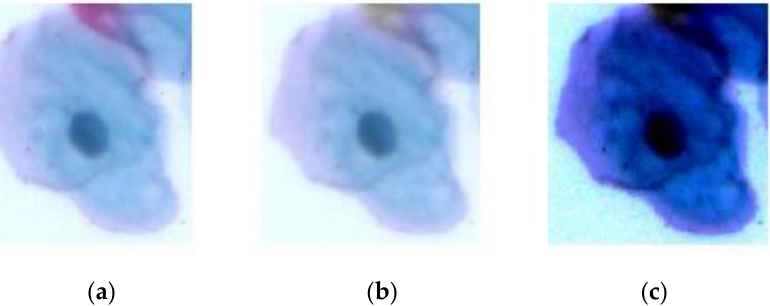
Figure 3. Image enhancement: ( a ) original image, ( b ) noise removal via the median filter, and ( c ) contrast enhancement via histogram equalisation.